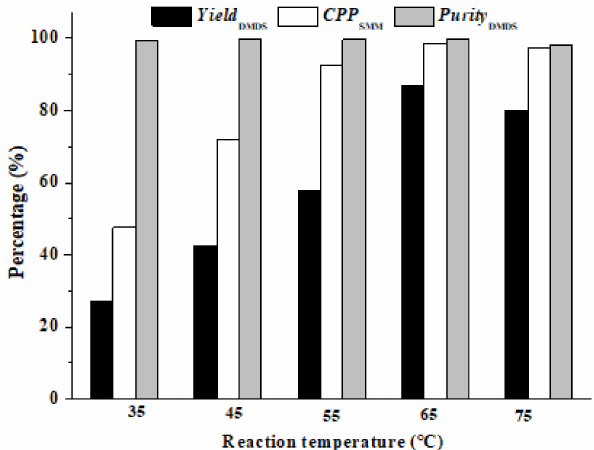
Figure 9. The effect of reaction temperature on CPP SMM , Yield DMDS , and Purity DMDS using the AC-CoPcS catalyst. Experimental conditions: SMM (18.0 wt%) 450 g, RR = 600 r/min, C ca = 888.9 ppm, t = 60 min, P (O 2 ) = 0.9 MPa.